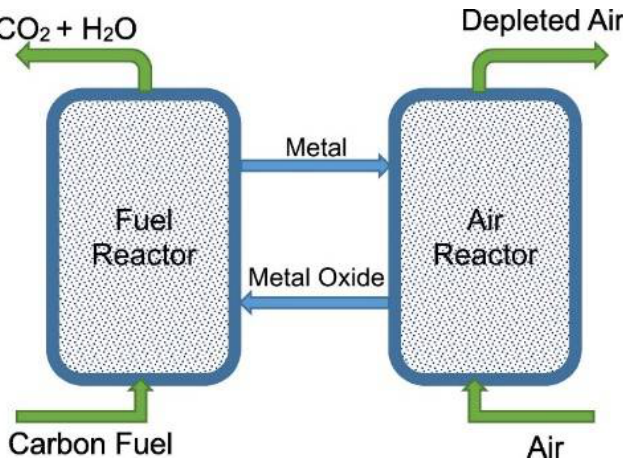
Figure 6. Schematic diagram of chemical looping combustion. Reproduced with permission from [93], Elsevier, 2021.